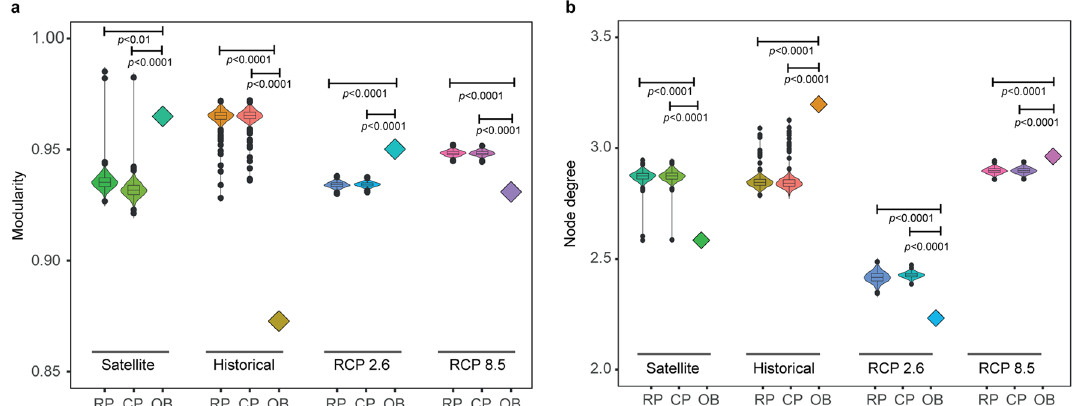
Figure 3. Statistical analysis of networks. ( a ) Modularity; ( b ) Node degree. Panels show violin and box plots derived from null models under random and constant phase randomization (RP and CP, respectively; n = 1000) and observed (OB) statistics for remotely sensed SSTs (satellite) and for each of the Historical, RCP 2.6 and RCP 8.5 emission scenarios considered in this study. Violin plots show kernel density estimates at different values of the data; box-plots show the median, an upper and lower hinge corresponding to the 25th and 75th percentiles of the distribution (first and third quartiles) and the whiskers, which show data dispersion up to 1.5 times the inter-quantile range; points are